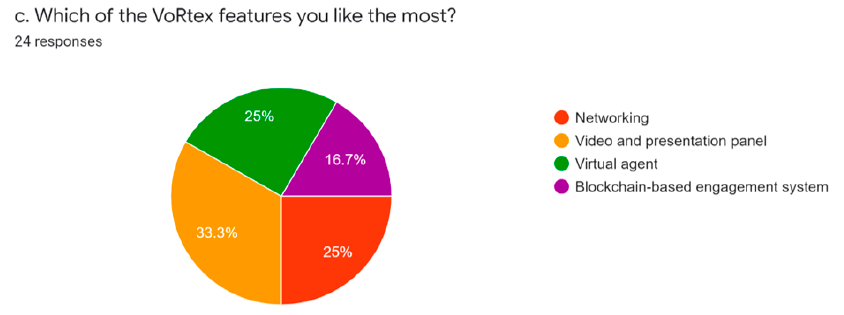
Figure 14. VoRtex test results from Google Forms report. Metrics about VoRtex features.